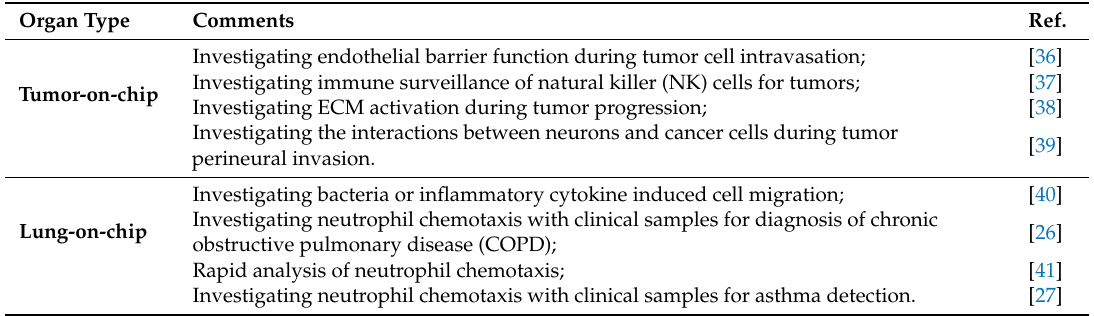
Figure 1. A schematic illustration of different cell migration research approaches to study this important and complicated process in humans. ( A ) Schematic presentation of human body and transendothelial migration of immune cells. ( B ) Schematic presentation of in-vivo animal models. ( C ) Schematic presentation of in-vitro cell migration assays. ( D ) An example of the organ-on-chip approach. Figure 1D was adapted from reference [35] with permission from the Royal Society of Chemistry. BM: basement membrane; EC: endothelial cell; ECM: extracellular matrices. Table 1. Summary of cell migration studies using organ-on-chip-related approaches.